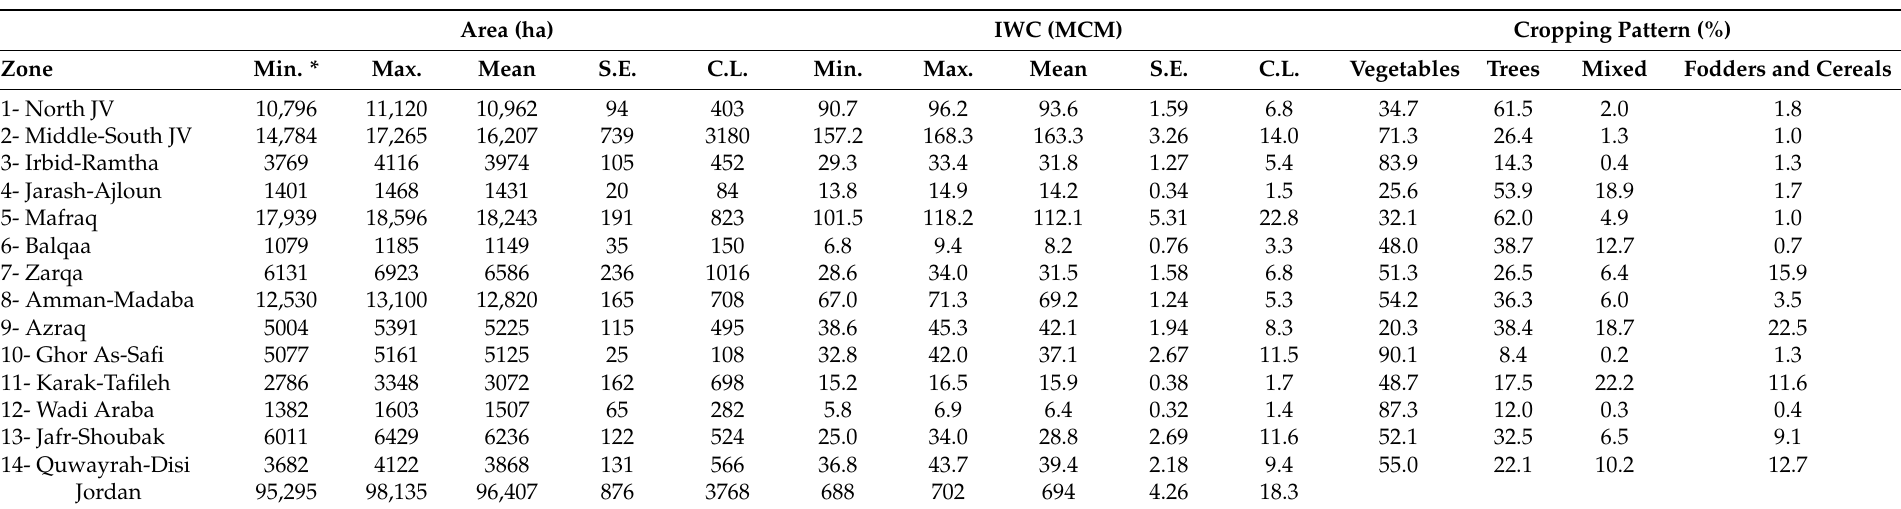
Table 5. Summary of irrigated areas, IWC, and cropping patterns in the irrigated zones in Jordan during 2017–2019. Area (ha) IWC (MCM) Cropping Pattern